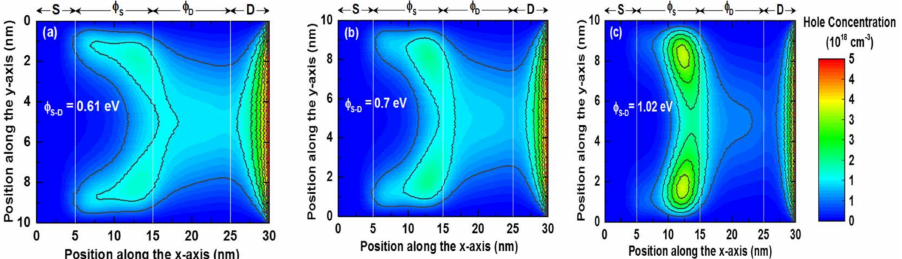
Figure 7. Hole concentration contours at on-state (V DD = V GS = − 0.5 V) for ( a ) ∆ φ S-D = 0.61 eV, ( b ) ∆ φ S-D = 0.7 eV, and ( c ) ∆ φ S-D = 1.02 eV.